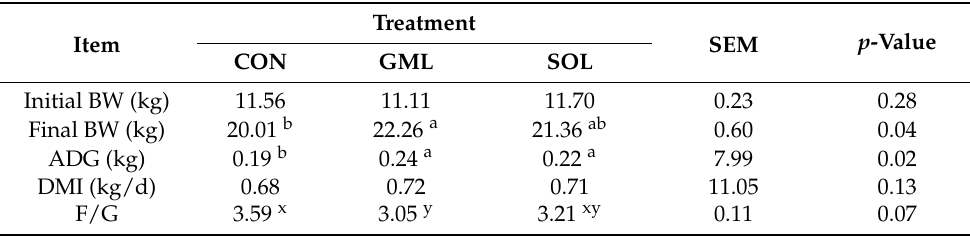
Table 2. Effects of monoglyceride laurate and Solider on the growth performance of nutrient sub- stances in weaned